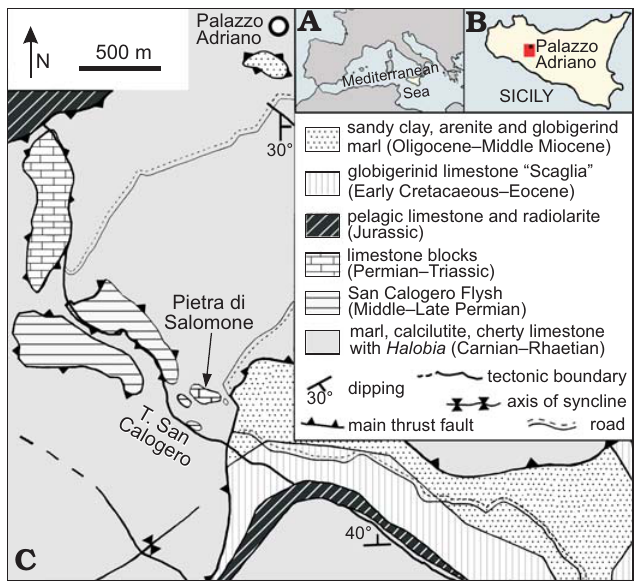
Fig. 1. A , B . Location of the study area in the Mediterranean and Sicily. C . Geological map of the Palazzo Adriano area (Sicani Mountains) show- ing the location of the “Pietra di Salomone” megablock (modified from Di Stefano and Gullo